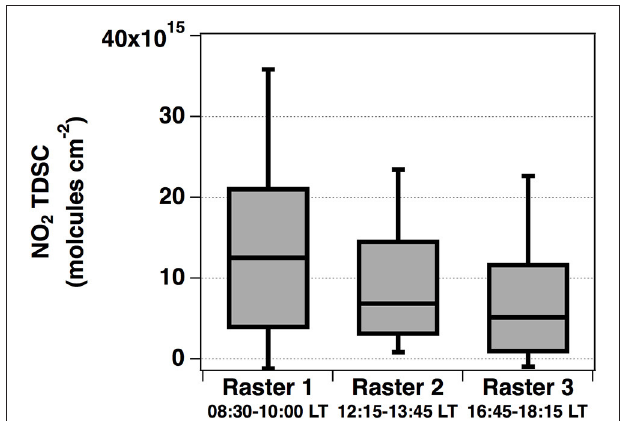
FIGURE 8 | Box plots showing the percentile distributions of NO 2 TDSCs for each raster in the LA Basin from Figure 7 . The shaded box shows 25th − 75th percentile range with the whiskers extending to the 5th and 95th percentiles. The solid line dividing each shaded box is the median.